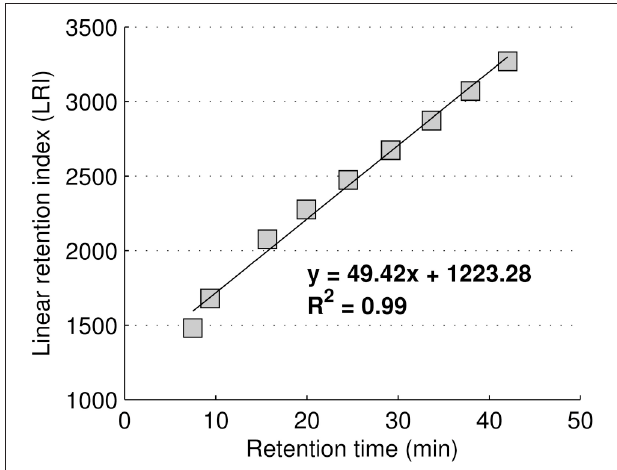
FIGURE 1 | Regression equation used to calculate the linear retention index using FAME internal